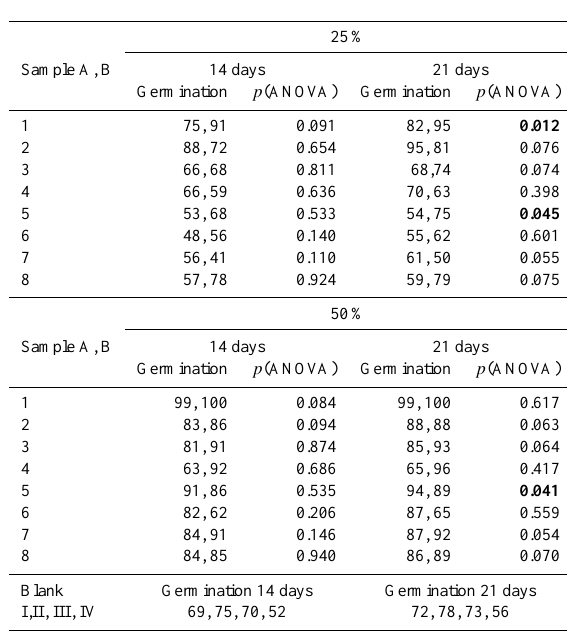
Table 3. Analysis of